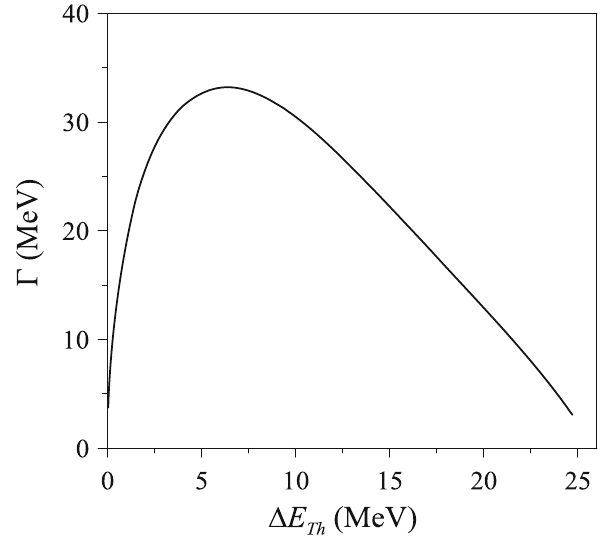
Fig. 1 Widthoftheresonance, (cid:3) ,asafunctionoftheenergydifference between its mass and the mass of the lower threshold generating the state, (cid:4) E Th = W R − m 1 − m 2 . The upper channel is 25.6 MeV above the lower